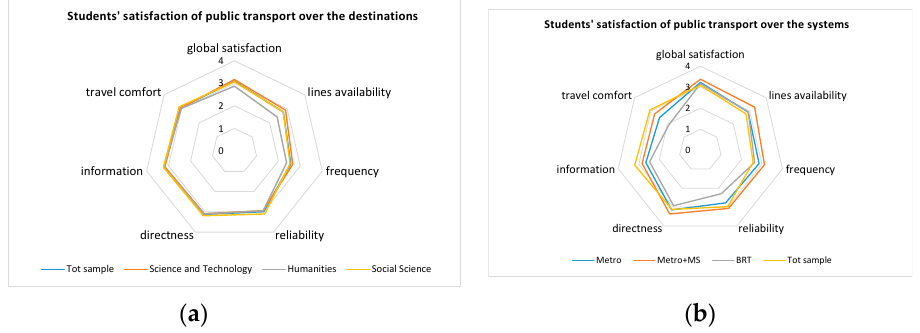
Figure 5. Students’ satisfaction of PT quality factors: ( a ) over the destinations; ( b ) over the PT systems (adapted from [65]).